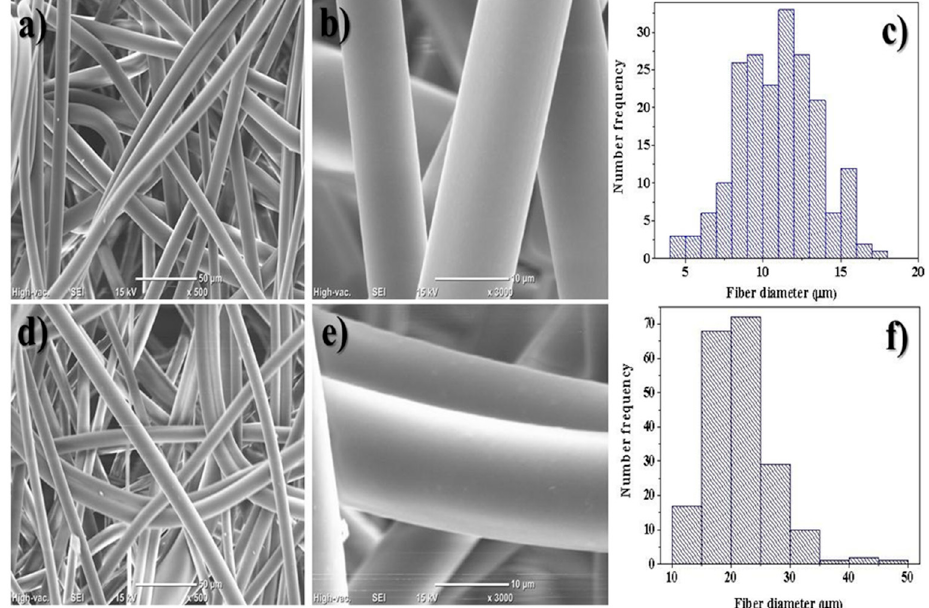
Figure 6. ( a ) Micrography of Ny6 Zytel/CB 0.25% nonwoven fabrics at 500X. ( b ) Micrography of Ny6 Zytel/CB 0.25% nonwoven fabrics at 3000X. ( c ) Histogram of size distribution of Ny6 Zytel/CB 0.25% fibers. ( d ) Micrography of Ny6 Zytel/CB 4% nonwoven fabrics at 500X. ( e ) Micrography of Ny6 Zytel/CB 4% nonwoven fabrics at 3000X. ( f ) Histogram of size distribution of Ny6 Zytel/CB 4%.